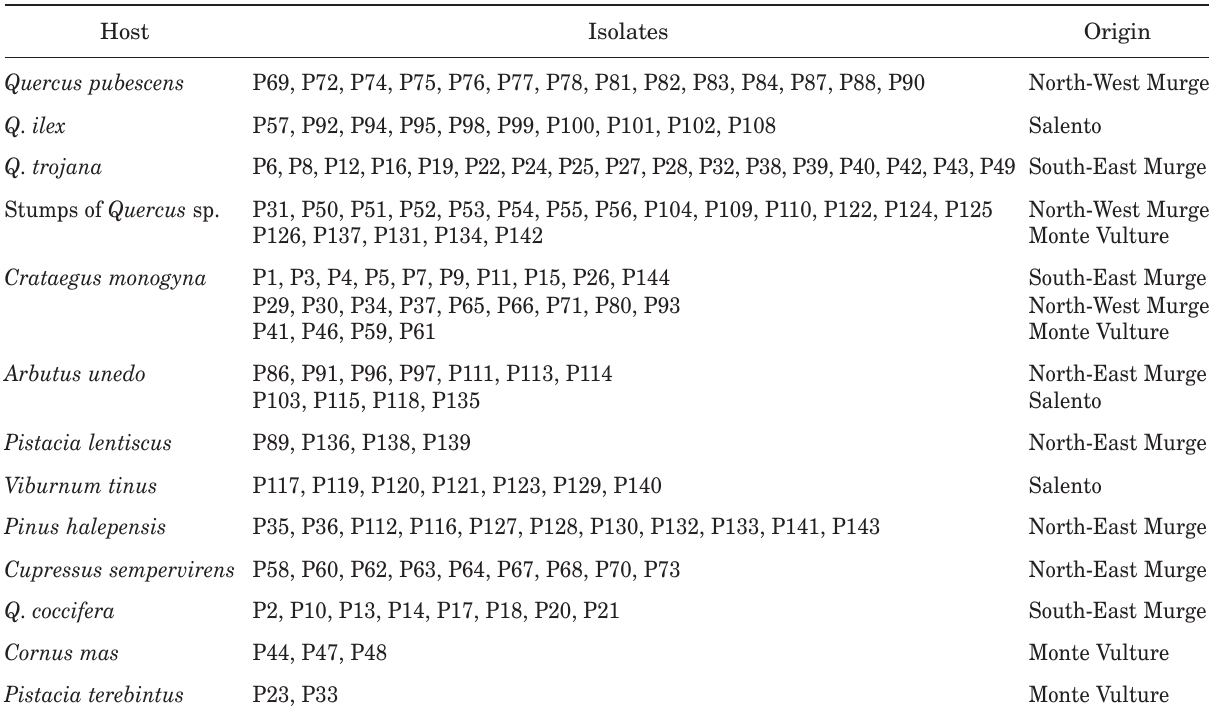
Table 3. Isolates of Phellinus torulosus (P) used in this